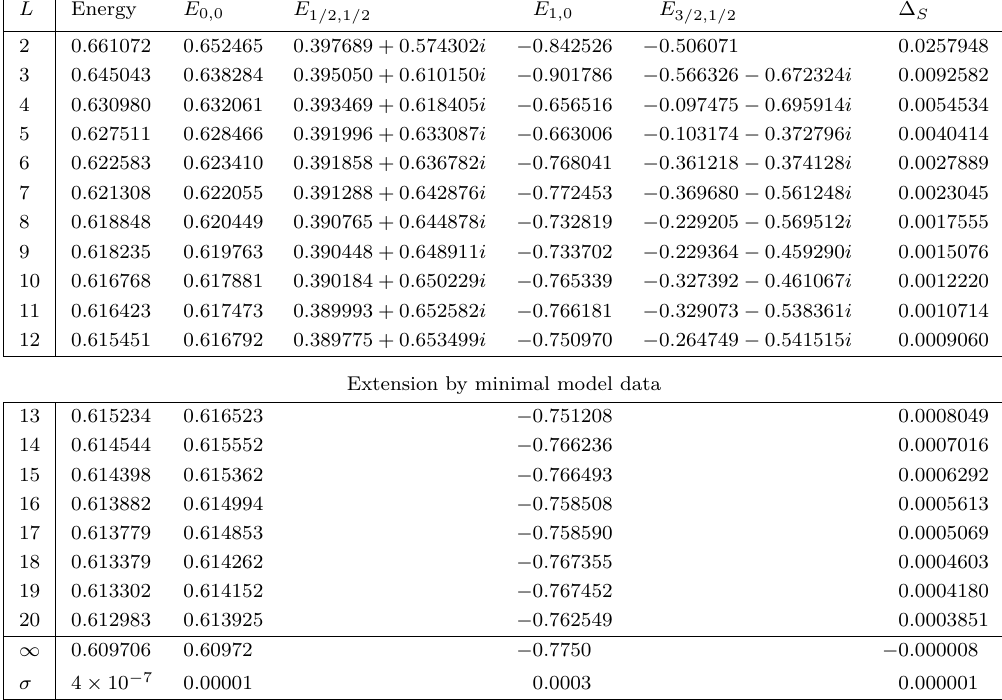
Table 4 . Independent gauge invariants of a solution describing 0-brane with θ = π/ 3 in the k = 3 model with J = 1 boundary conditions. The second part of the table includes higher level predictions 2 based on m = 5 minimal model